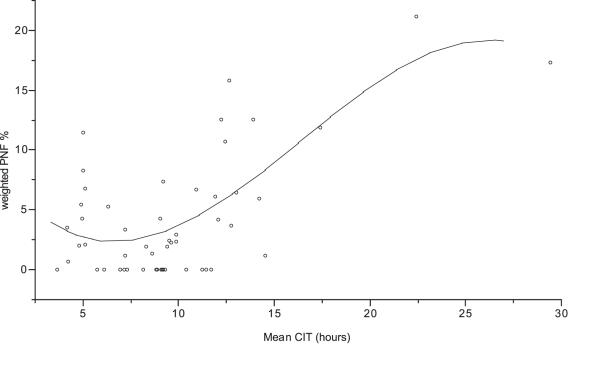
Weighted PNF (%) vs. mean CIT for each study subgroup.PNF% = −6.678281+0.9134701*CIT Mean+0.1250879*(CIT Mean−9.89535)2−0.0067663*(CIT Mean−9.89535)3. r2 = .625. p = <.0001.